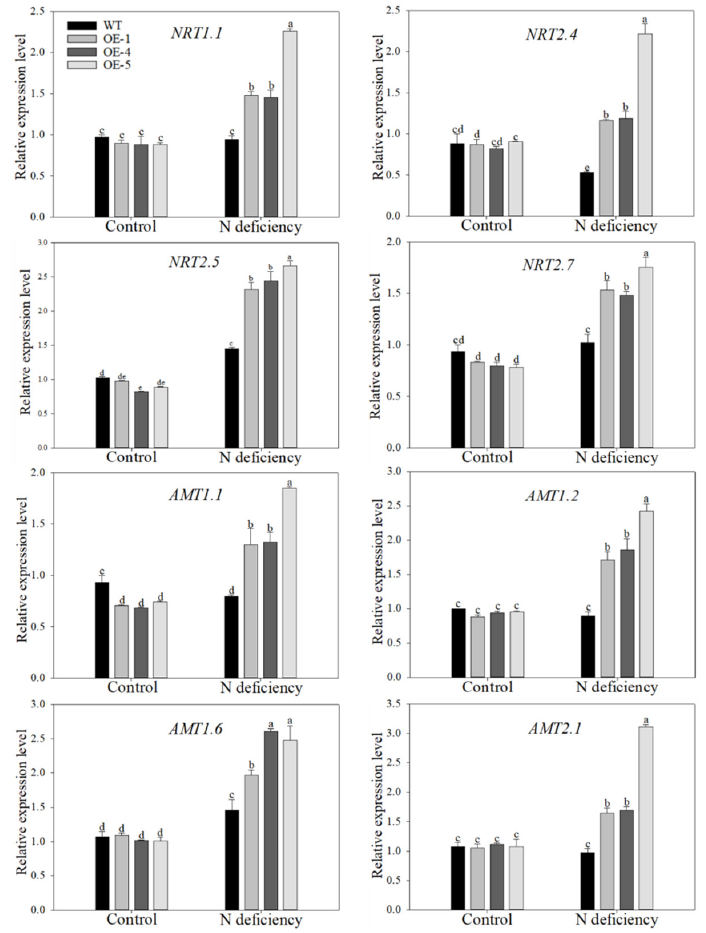
Figure 7. Changes in transcript levels of genes involved in nitrogen absorption in apple following nitrogen-deficiency treatment. Data are shown as the means of three replicates with SEs. Different letters indicate significant differences between treatments, according to one-way ANOVA followed by Tukey’s multiple range test ( p < 0.05).